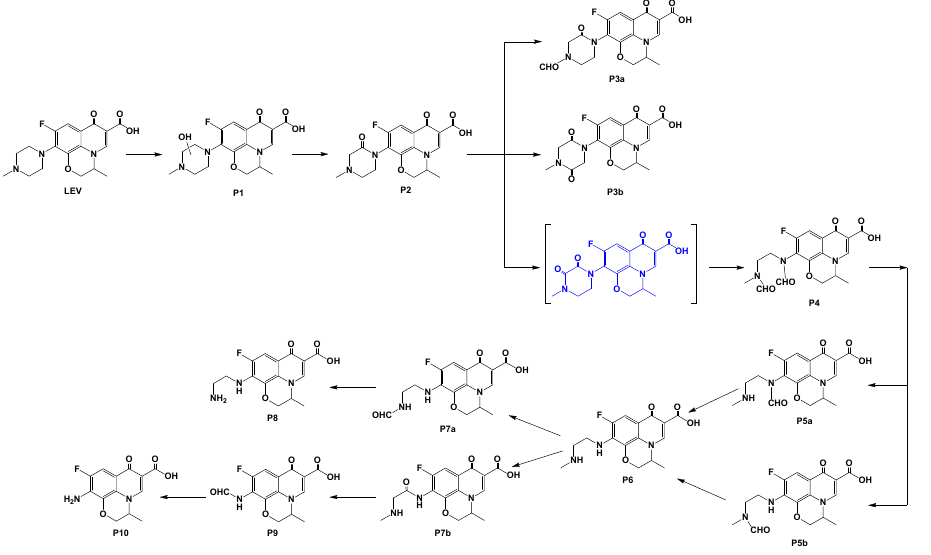
Figure 8. Proposed pathways (i) of the degradation of LEV.